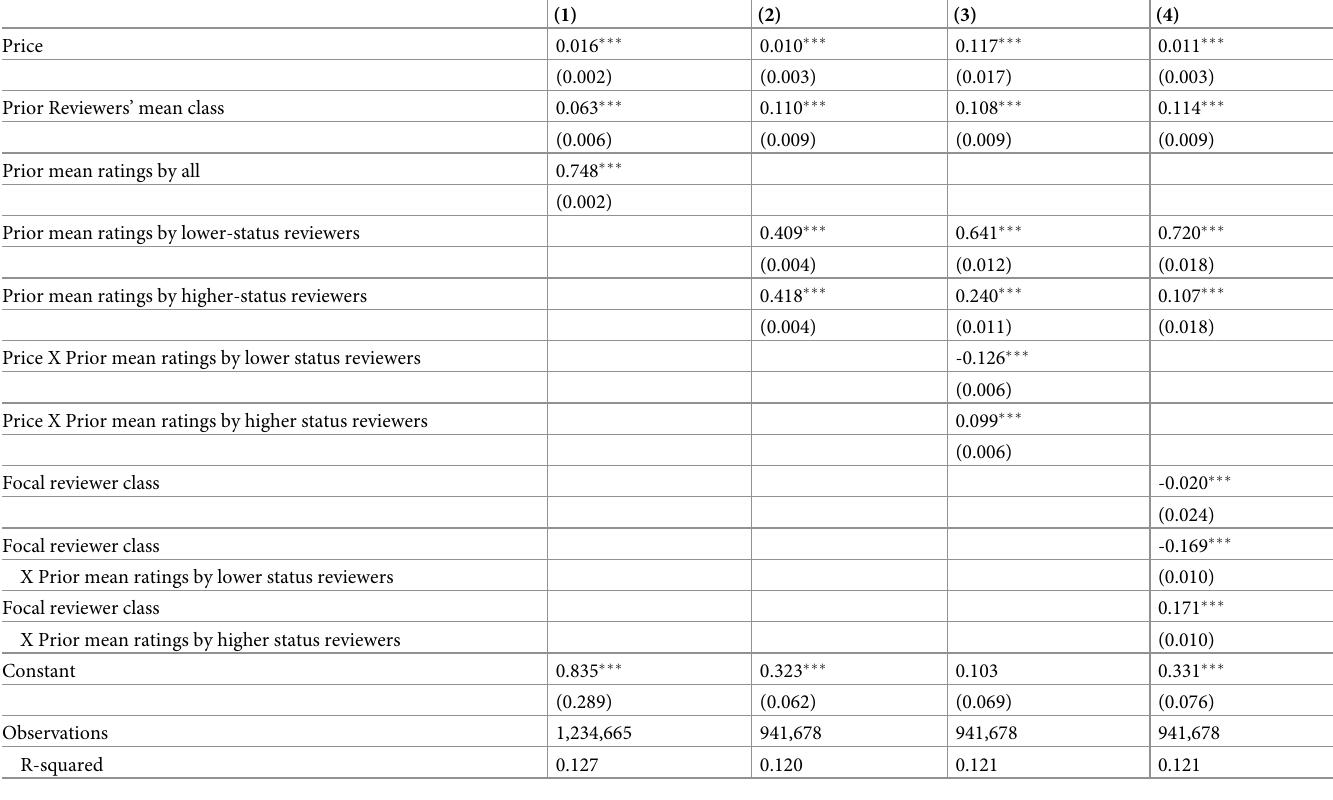
Table 2. Study 1: OLS regressions. Dependent variable: focal star rating. Independent variables: the reviewed organization’s price level, the social class composition of the existing clientele, the mean of prior star ratings, and the focal reviewer’s social